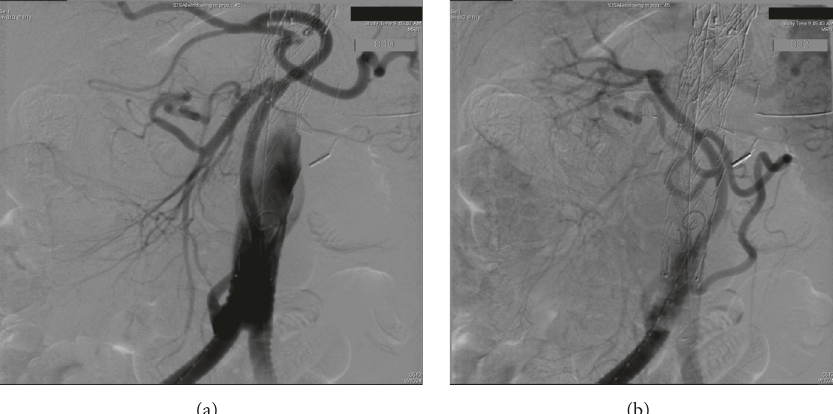
Figure4:Normalbloodflowinthesuperiormesentericartery,celiactrunk(a),andrightrenalartery(b)isdemonstratedontheintraoperative angiogram after retrograde graft revascularization of these